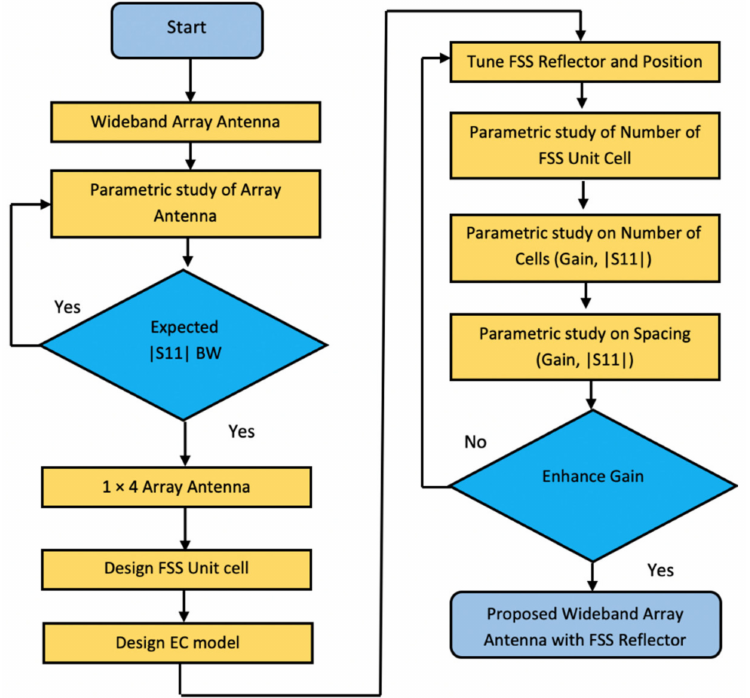
Figure 15. The flowchart for developing the proposed array antenna with FSS.